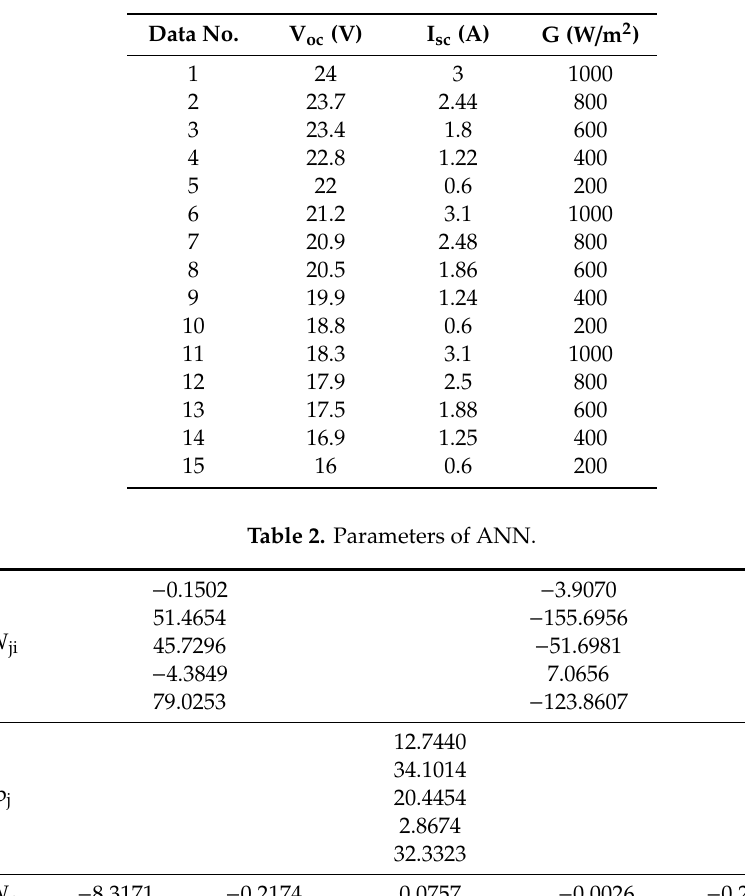
Table 1. Data sets for artificial neural network (ANN).